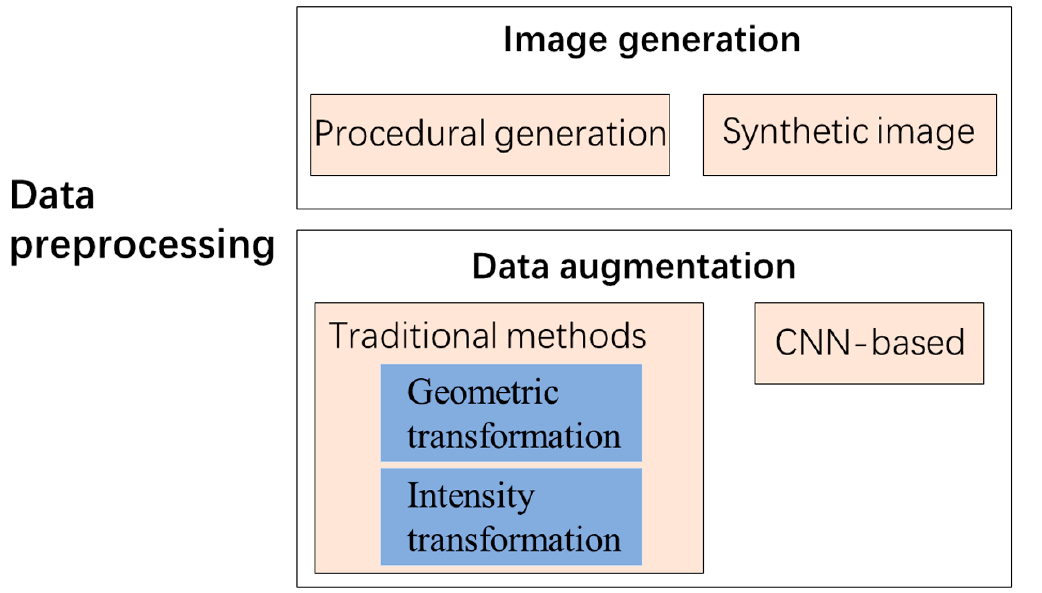
Figure 6. Methods of Data Preprocessing.